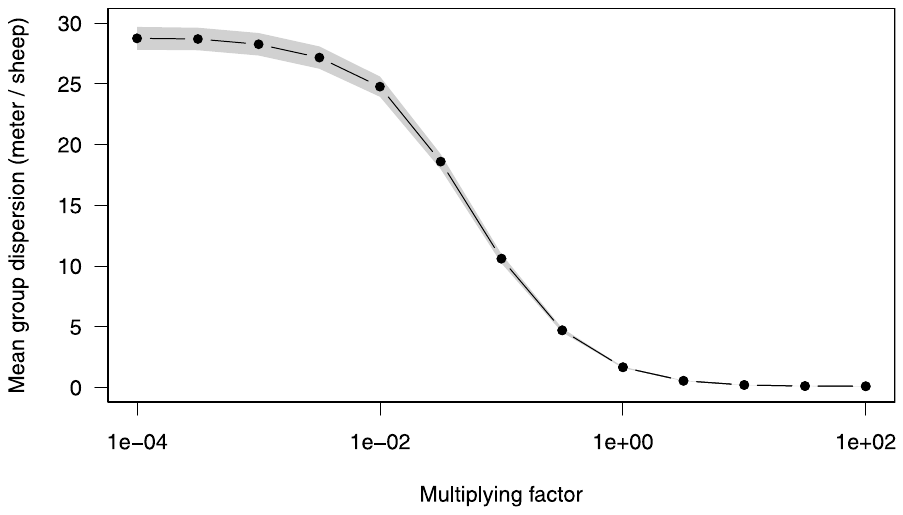
and α by a multiplying A I